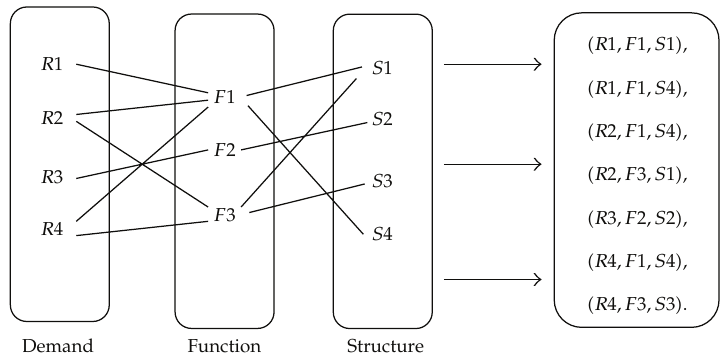
Figure 1: Relationships among demand, function, and structure.